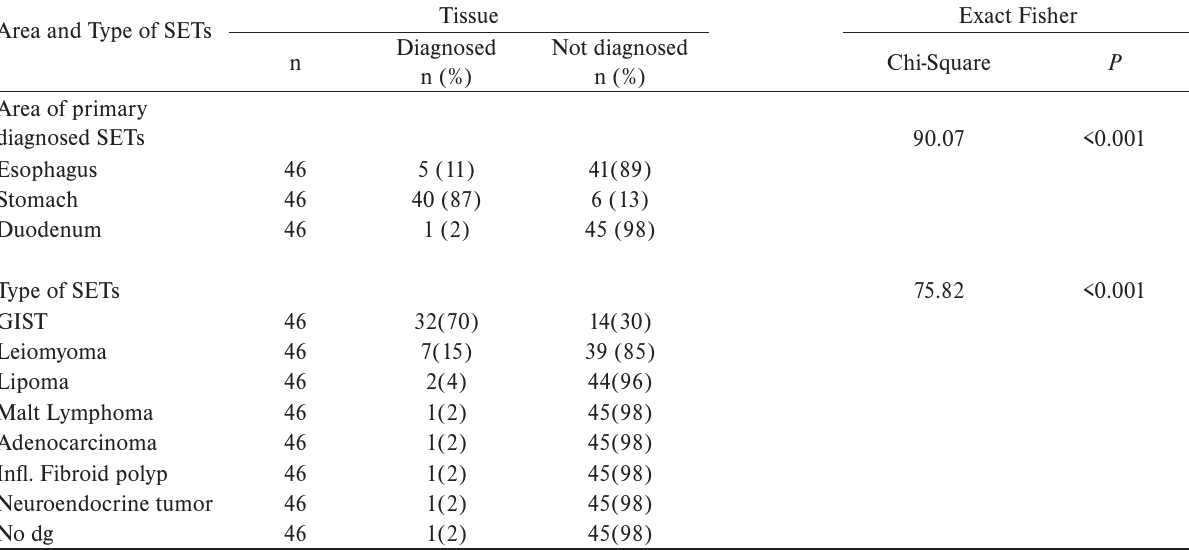
Table 3. Area and type of diagnosed subepithelial tumors